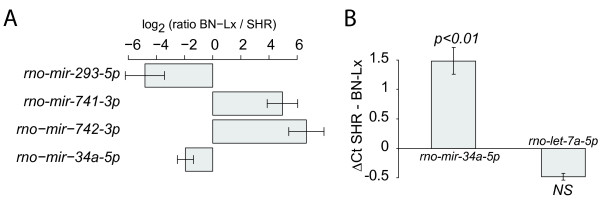
Strain-specific miRNA expression. A) Strain-differentially expressed miRNAs in the liver. The error bars indicate the estimated standard deviation (see methods for details). Only miRNAs of which the expression was significantly different (p < 0.05) are shown. The read frequency is normalized to the ocm (see methods for details). B) Differential expression of mir-34a confirmed by qPCR. The barplots show ΔCt values. This data was obtained from 3 × 3 replicates of each strain. The error bars show the combined standard deviation of all replicates for each miRNA. The student's T-test (2-sided) only assigned significance (p < 0.01) to mir-34a. NS, not significant.